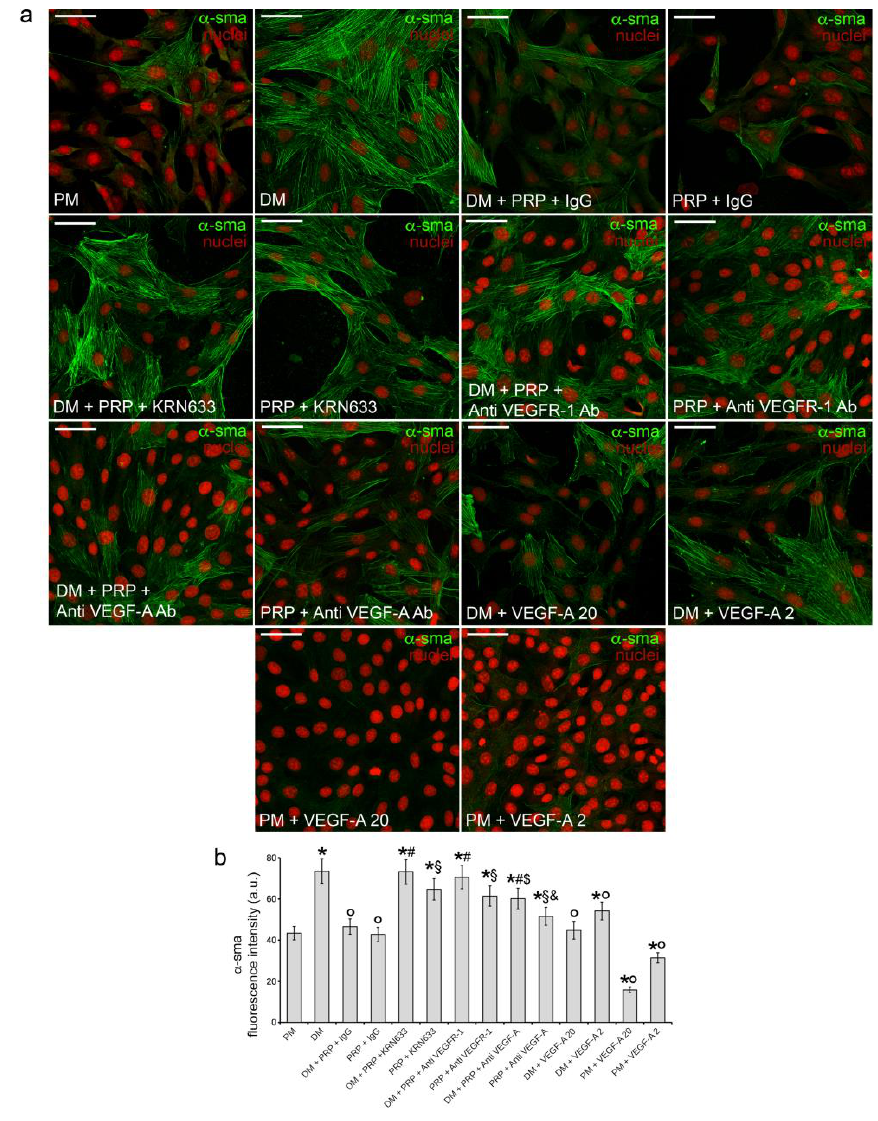
Figure 5. Effect of VEGFR-1 inhibition, VEGF-A neutralization, and stimulation with soluble VEGF-A on α -sma expression: confocal immunofluorescence analysis. NIH/3T3 fibroblastic cells were cultured in differentiation medium (DM, low serum medium plus 2 ng/mL TGF- β1) in the absence or presence of 1:50 diluted PRP + irrelevant IgG (DM + PRP + IgG) or in the presence of 1:50 serum-free medium diluted PRP + IgG. To evaluate the involvement of VEGF-A/VEGFR-1 mediated signaling in PRP-induced fibroblast response, the cells were treated with the selective pharmacological VEGFR inhibitor, KRN633 (DM + PRP + KRN633; PRP + KRN633) or with anti-VEGFR-1 neutralizing antibodies (8 µg/mL; DM + PRP+ Anti VEGFR-1 Ab; PRP + Anti VEGFR-1 Ab) or anti-VEGF-A neutralizing antibodies (10 µg/mL ; DM + PRP+ Anti VEGF-A Ab; PRP + Anti VEGF-A Ab). In parallel experiments the cells were cultured in DM or PM in the presence of two different concentrations of soluble VEGF-A (20 ng/mL, DM + VEGF-A 20, PM + VEGF-A 20; 2 ng/mL, DM + VEGF-A 2, PM + VEGF-A 2). Cells cultured in proliferation medium (PM) served as control undifferentiated cells. ( a ) Representative confocal fluorescence images of the cells immunostained with antibodies against α -sma and counterstained with propidium iodide to reveal nuclei. Scale bar: 50 µm. ( b ) Histogram showing the densitometric analysis of the intensity of α -sma fluorescence signal performed on digitized images. Data shown are mean ± S.E.M. and represent the results of at least three independent experiments performed in triplicate. Significance of difference: * p < 0.05 vs. PM; ° p < 0.05 vs. DM; # p < 0.05 vs. DM + PRP + IgG; § p < 0.05 vs. PRP + IgG; $ p < 0.05 vs. DM + PRP + Anti VEGFR-1 Ab; & p < 0.05 vs. PRP + Anti VEGFR-1 Ab.